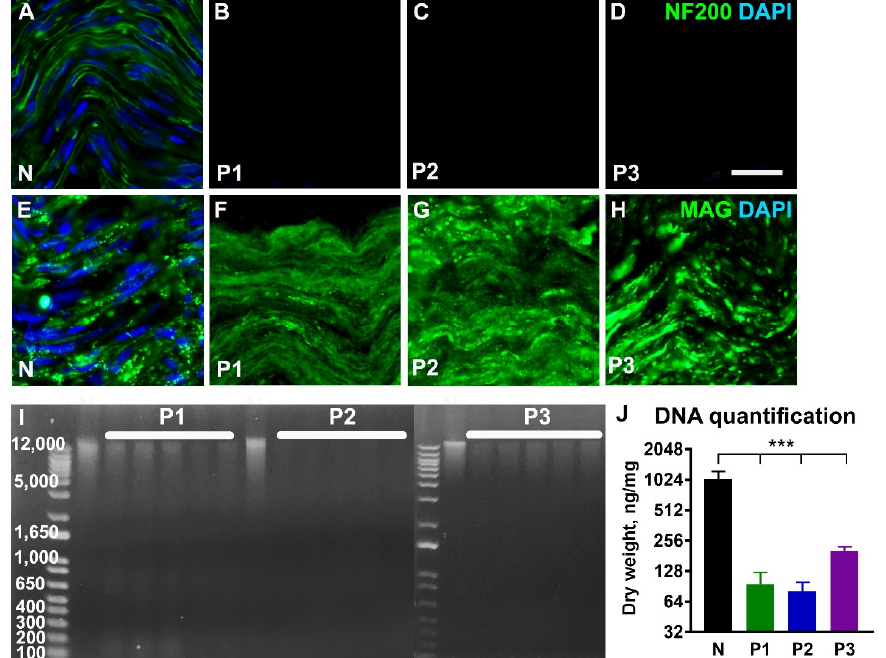
Figure 2. Characterization of the decellularized nerve tissue. Representative longitudinal sections from normal nerve (N) and decellularized nerves following treatment with protocols P1, P2, and P3 and immunostained for axonal neurofilaments (NF 200, ( A – D )) and myelin-associated glycoprotein (MAG, ( E – H )). Cell nuclei are counterstained with DAPI. The agarose gel electrophoresis in (( I ), n = 5) and histogram in (( J ), n = 5) shows significant reduction of the genomic DNA following treatments. Error bars show the S.E.M. p < 0.001 is indicated by ***. Scale bar, 25 µm. Analysis of extracellular matrix proteins showed that collagen was preserved in all nerve samples when compared with untreated nerves (Figure 3A–D and Figure 3I), whereas laminin was only found in nerves treated with the P2 protocol (Figure 3 E–H). Quantification of glycosaminoglycans revealed a significant decrease following treatment with P2 protocol when compared with both the naïve nerve and nerves treated with pro- tocols P1 and P3 ( p ≤ 0.05; Figure 3J).